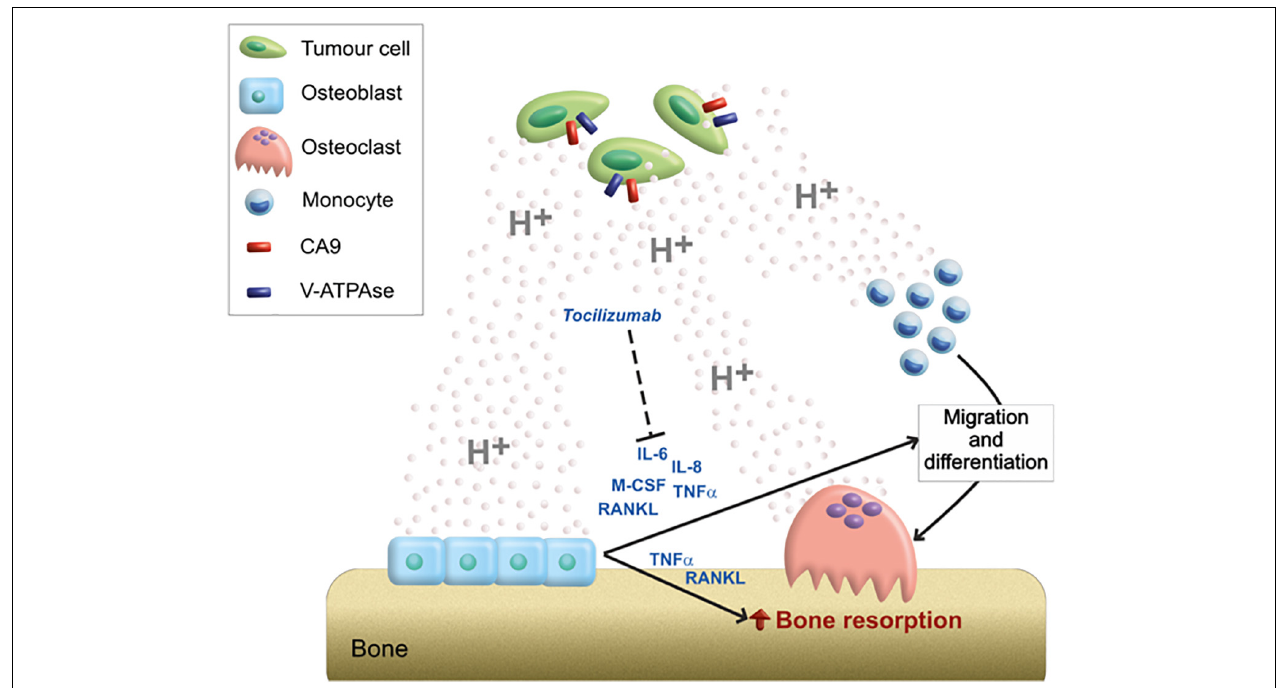
FIGURE 6 | Graphical scheme of the mechanistic model proposed for the role of acidosis on the bone remodeling unbalance. Tumor cells acidifying the extracellular environment through the activity of CA9 and V-ATPase; acidosis can directly stimulate the migration of OC precursors and activate bone-resorbing OC; however, the high amount of protons in the extracellular space can also induce the release of a pro-osteoclastigenic secretome by OB (IL-6, IL-8, M-CSF, TNF α , and RANKL). The paracrine mediators secreted by acidosis-induced OB, might, in turn, further exacerbate the OB–OC coupling responsible for osteolysis. Among them, the targeting of IL-6 by the anti-IL-6R antibody (Tocilizumab) blocks the acidosis-promoted and osteoblast-mediated induction of OC differentiation and